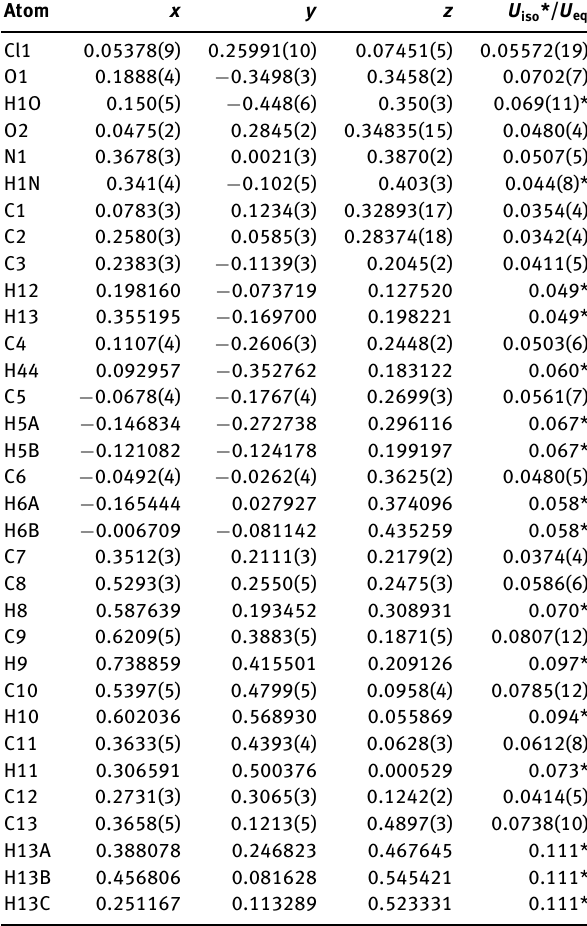
Table 2: Fractional atomic coordinates and isotropic or equivalent isotropic displacement parameters (Å 2